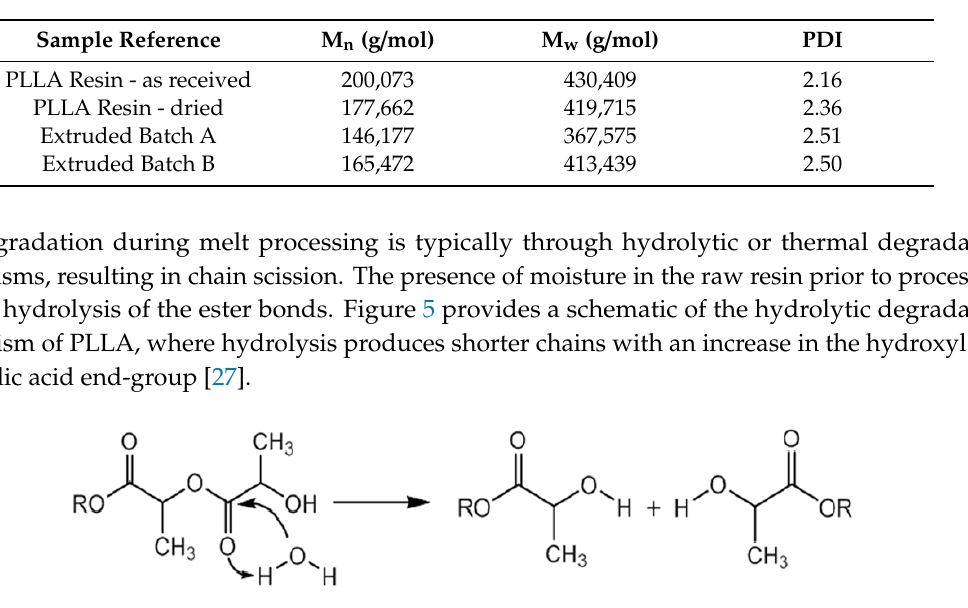
Figure 5. Hydrolytic degradation of PLLA, reproduced from [28] under open access license.